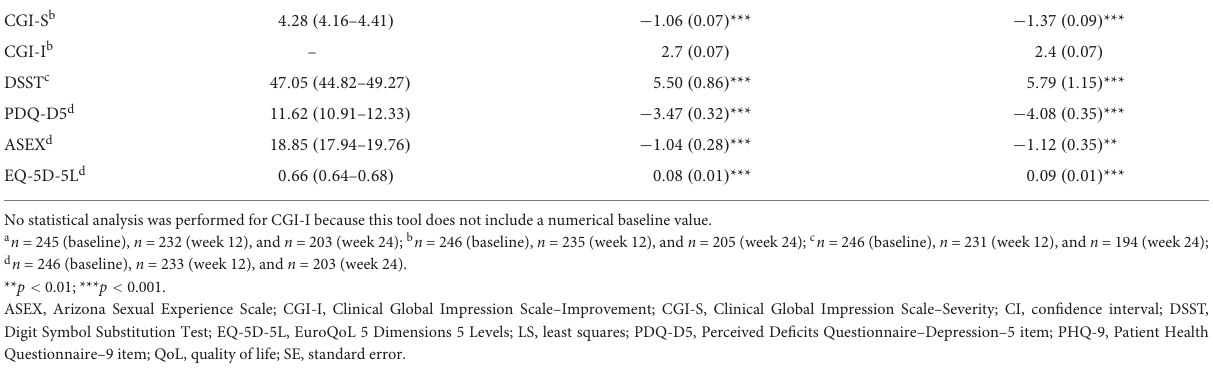
TABLE 2 Changes in adjusted LS mean scores from baseline to weeks 12 and 24 for depression severity, cognitive and sexual function, and QoL. Baseline score, adjusted Change from baseline to Change from baseline to LS mean (95% CI) week 12, adjusted LS mean (SE) week 24, adjusted LS mean